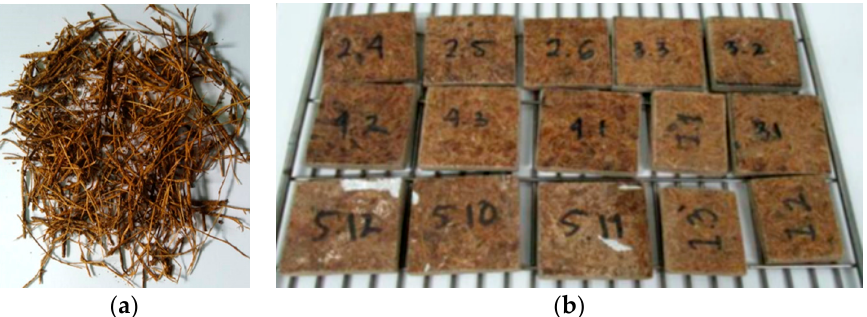
Figure 1. ( a ) Clean and dry sago fiber; ( b ) sago fiber-epoxy composite: E9 (1.1, 1.2, 1.3), E13 (2.4, 2.5, 2.6), E17 (3.1, 3.2, 3.3), E20 (4.1, 4.2, 4.3), E23 (5.10, 5.11, 5.12) .